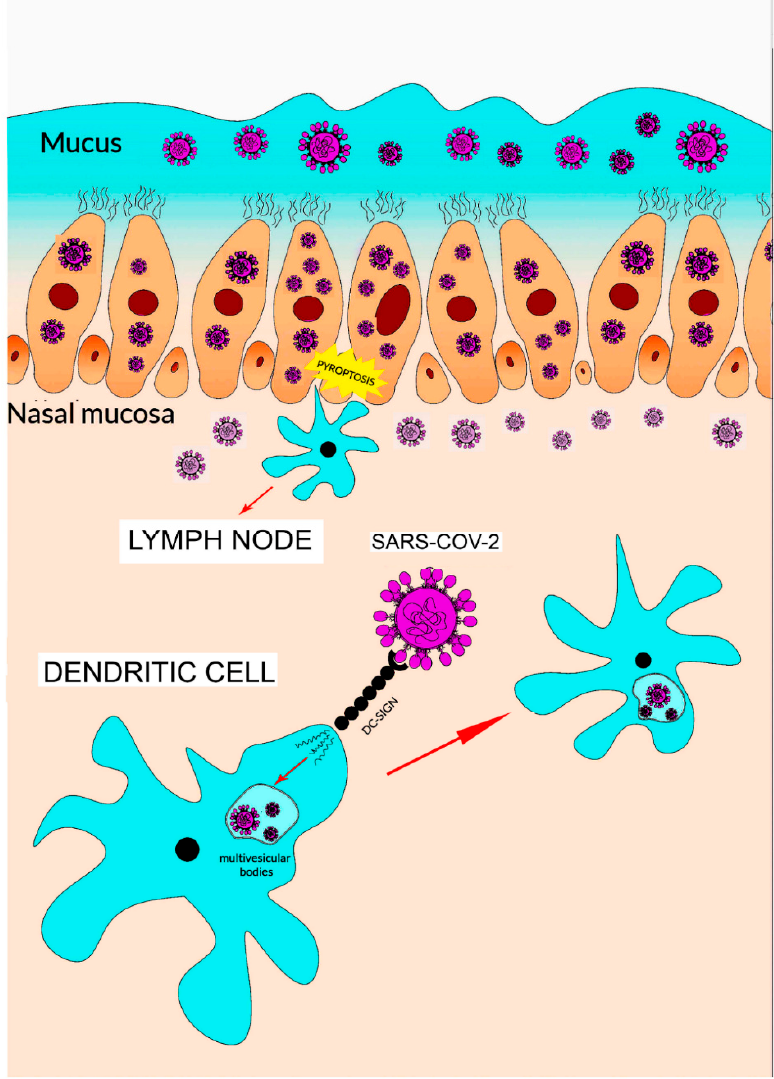
Figure 3. Scheme showing the putative dendritic cells involvement in SARS-CoV-2 entry through nasal epithelial cells. The entry of SARS-CoV-2 through epithelial cells is followed by pyroptosis and activation of dendritic cells in a manner similar with that reported in Figure 2. Particularly, the interaction between DC-SIGN and the virus is shown. The binding (and DAMP and PAMP interaction that is not shown) could cause the virus to spread from the nasal epithelial cells to the rest of human